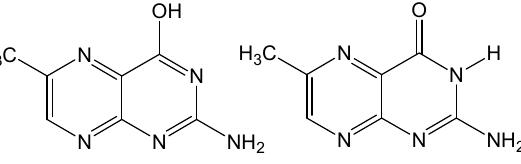
Figure 1: Lactim (left) and lactam (right) structures of